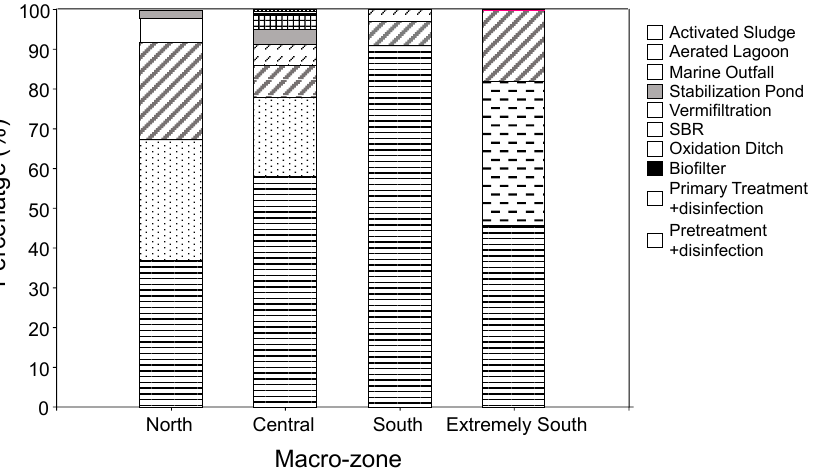
Figure 3. Municipal wastewater treatment technologies applied by macrozone in Chile. North: 49 WWTP; Central: 209 WWTP; South: 33 WWTP; Extremely South: 11 WWTP; Total: 302 WWTP.